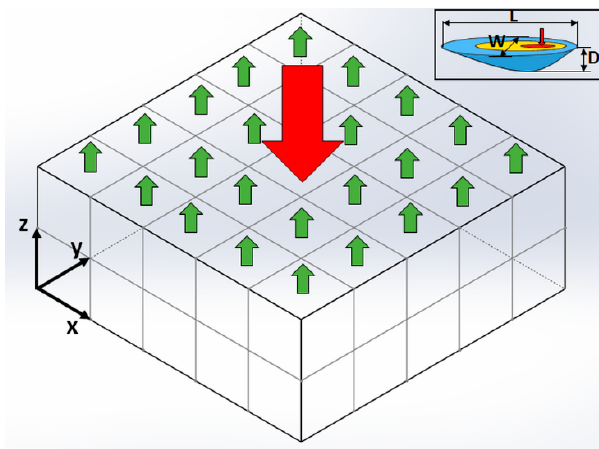
Figure 1. Schematic drawing of the heat transfer mechanism in PBMAM. The red arrow represents heat input from the laser source. The green arrows represent the heat loss from part boundary due to convection and radiation. Here, x , y , and z denote coordinate directions, while L , W , and D denote the molten pool length, width, and depth, respectively.